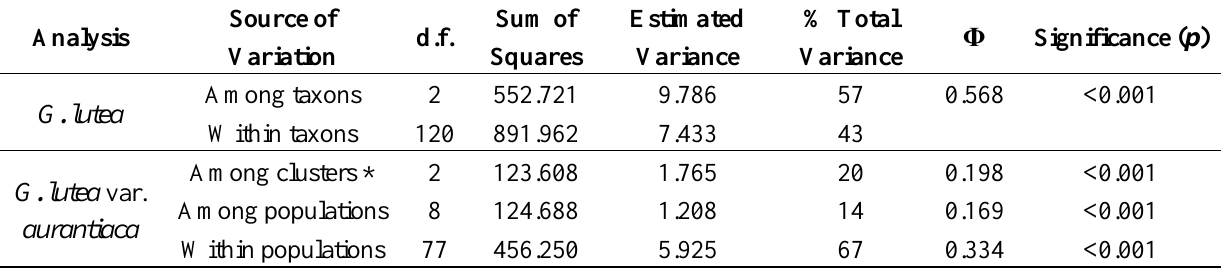
Table 2. Summary of the analysis of molecular variance (AMOVA) using